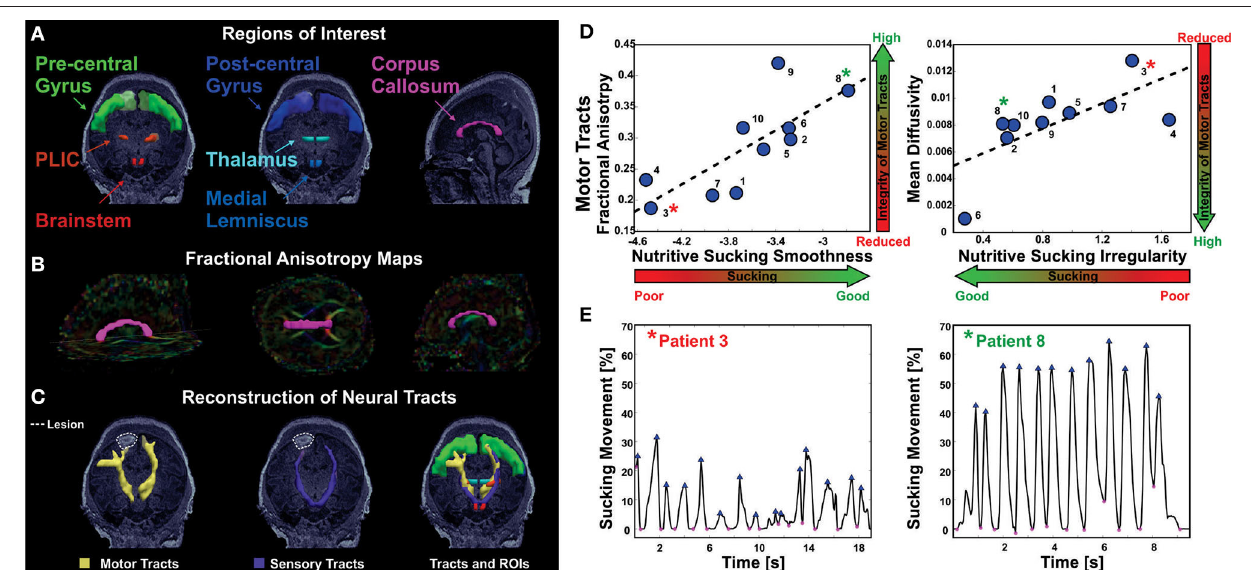
FIGURE 8 | Correlation of abnormal NS patterns with integrity of sensorimotor fibers in infants with established in infants with established brain injury [from Tamilia et al. ( 31)]. (A) Anatomically defined regions of interest overlaid on the T1 MRI of a female 4 day old preterm infant. On the left, regions of interest for the motor tracts; in the middle, regions of interest for the sensory tracts; on the right, regions of interest corresponding to the corpus callosum. (B) Corpus callosum (magenta) overlaid on the fractional anisotropy color-maps. (C) Axial view of the motor (in yellow) and sensory (in purple) tracts reconstructed via probabilistic diffusion imaging tractography, along with the regions of interest used for their delineation. Neural tracts and regions of interest are overlaid on the patient’s MRI that shows ischemic injury in the right frontal lobe. (D) The values of nutritive sucking smoothness and irregularity are predictive of the fractional anisotropy and mean diffusivity values, respectively, for the motor tracts. High smoothness in the nutritive sucking pattern, which is indicative of good sucking skills, is associated with high-fractional anisotropy, which is indicative of intact neural tracts. High irregularity in nutritive sucking, which is indicative of poor sucking skills, is associated with high-mean diffusivity, which is indicative of low integrity of neural tracts. (E) Two bursts of nutritive sucking from patients 3* and 8*. The left waveform demonstrates a poor NS behavior of patient 3 * characterized by low smoothness and high irregularity (i.e., presence of multiple peaks); while the right waveform demonstrates a good NS behavior of patient 8* characterized by the smooth and regular nutritive sucking